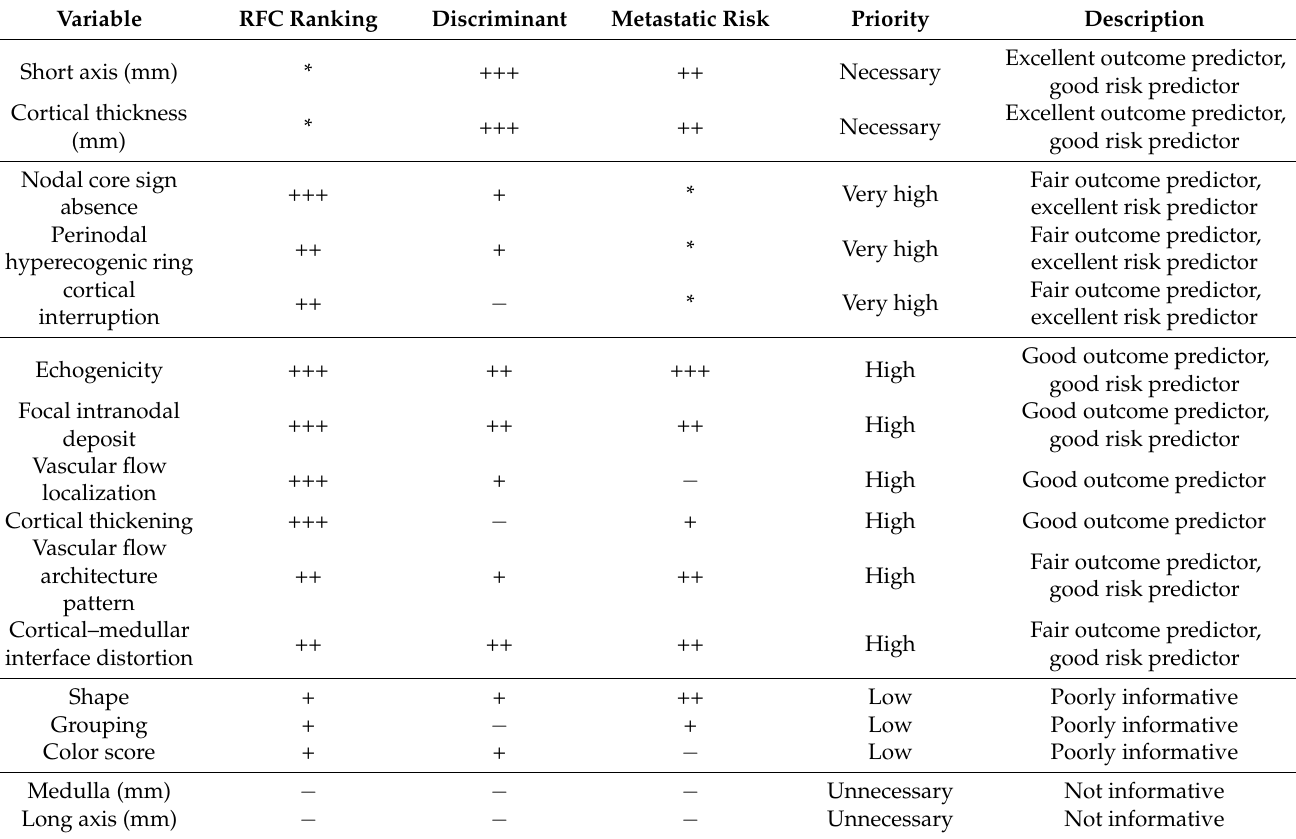
Table 2. Input variable